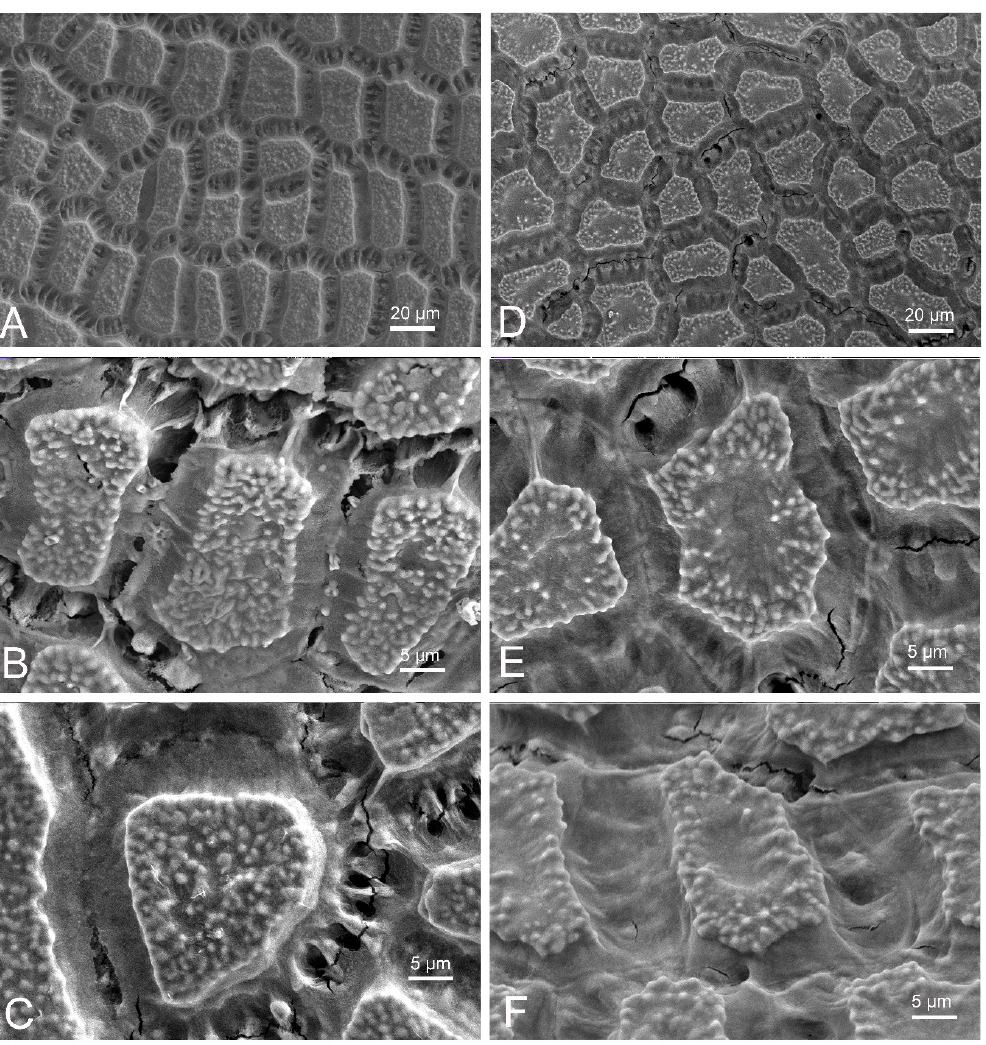
Figure 6. Scanning electron micrographs of seed testa sculptures. ( A – C ) Allium ducissae . ( D – F ) A. palentinum .